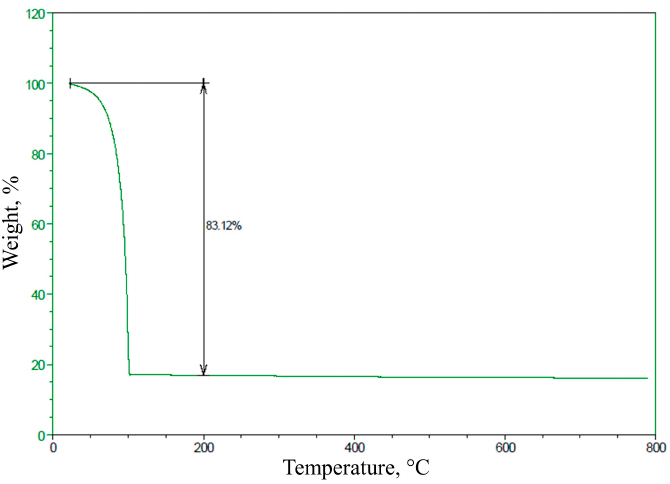
Figure 4. Thermogravimetric analysis of the AuNPs, showing an initial weight loss of 83.12% and a final weight corresponding to the presence of gold in the sample.